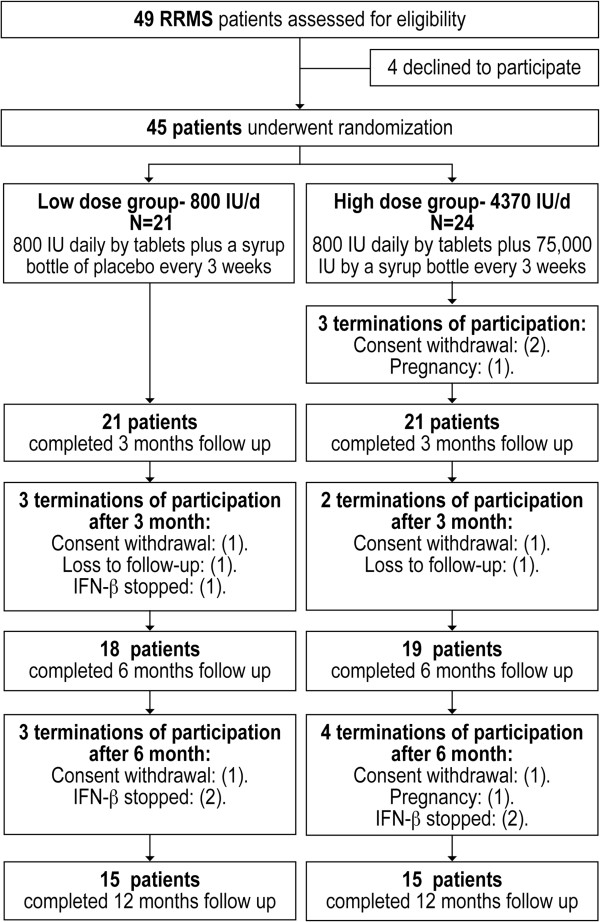
Study flow chart.